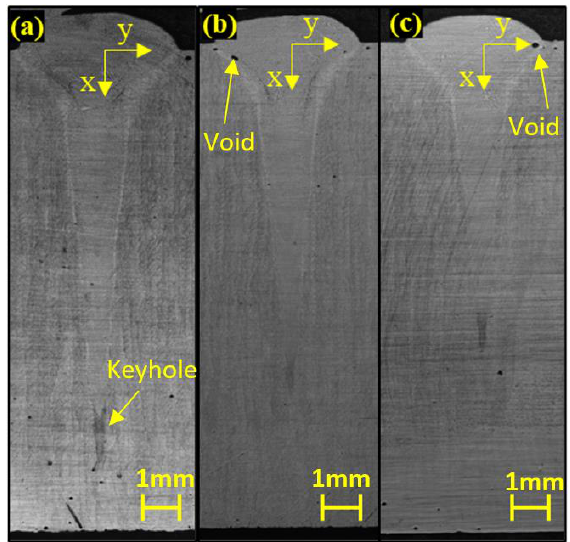
Figure 7: Typical nail-shape of weld profiles in samples (a) 11A (295J/mm), (b) 17A (213.2J/mm), and (c) 19A(180.4J/mm)